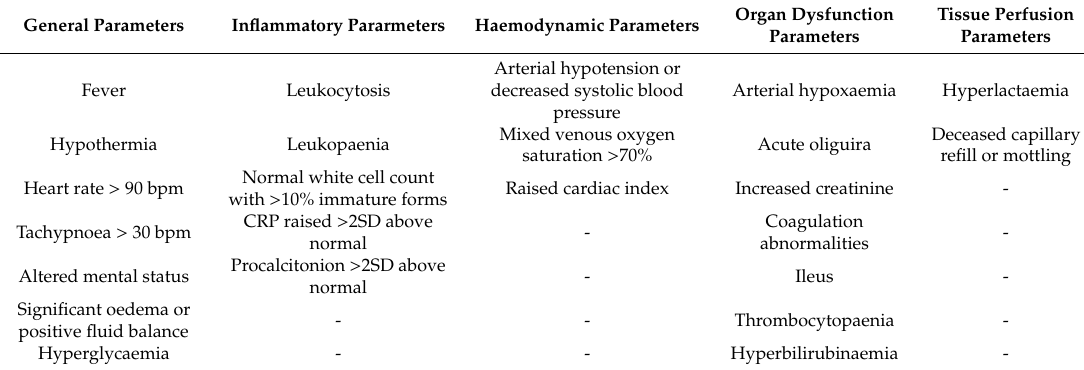
Table 2. Updated 2001 SIRS diagnostic criteria adapted from Levy et al.